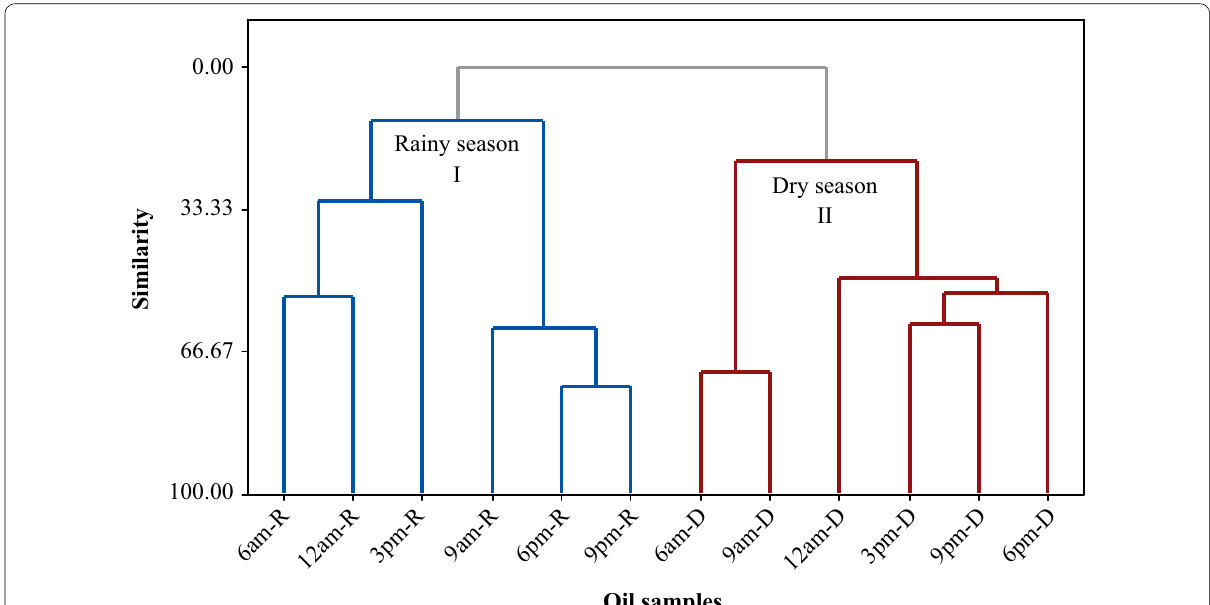
Fig. 5 Dendrogram representing the similarity relationship of the oils composition of L. thymoides in the circadian study, during the rainy